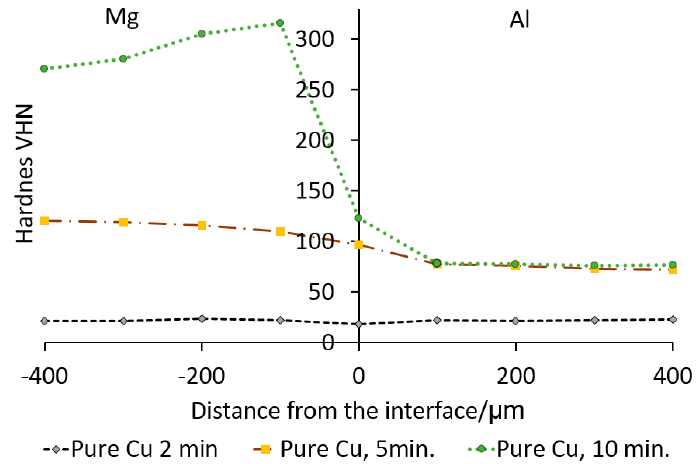
Figure 11. Micro-hardness profile for Mg/Al bonds as a function of bonding time using pure Cu interlayer.